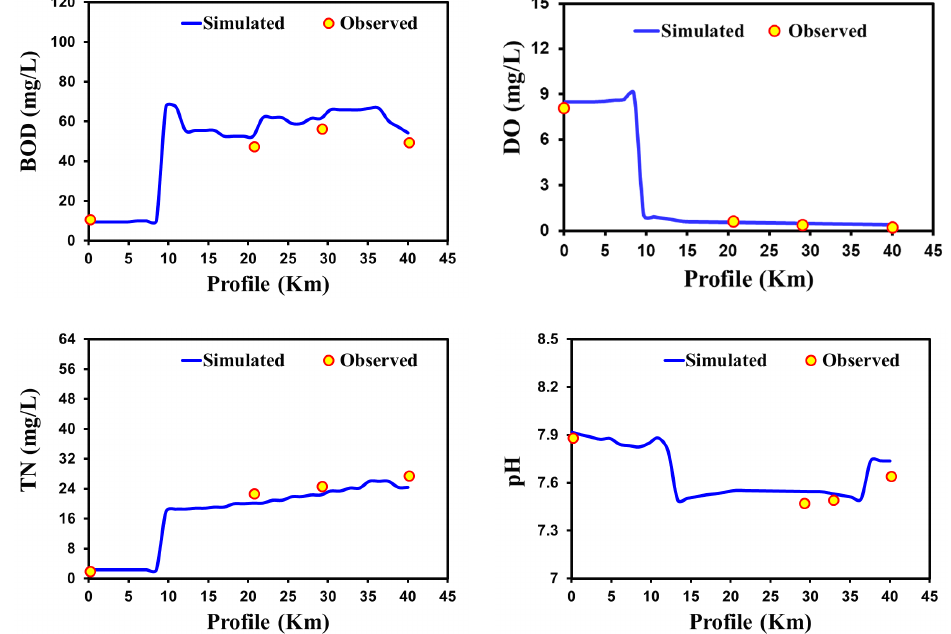
Figure 4. Confirmation of water quality model results in Yamuna River (arid climatic region) for BOD, DO, TN, and pH.